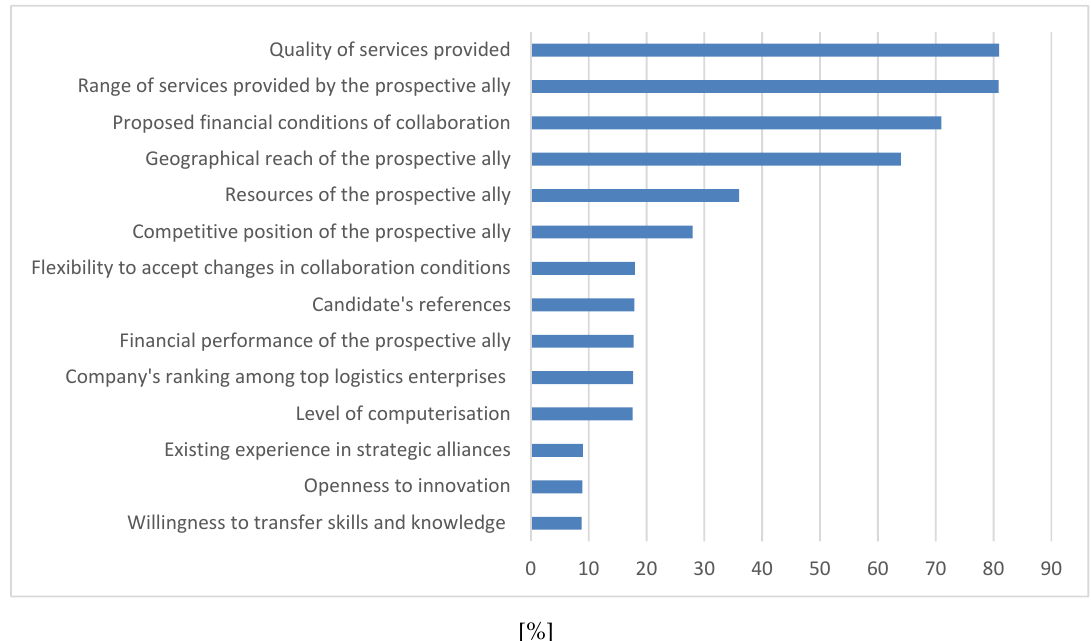
Figure 7. Sales of logistics, transport, and warehousing services in million Polish zlotys in the period 2005 to 2016 (Source: Main Office of Statistics, 2017b).